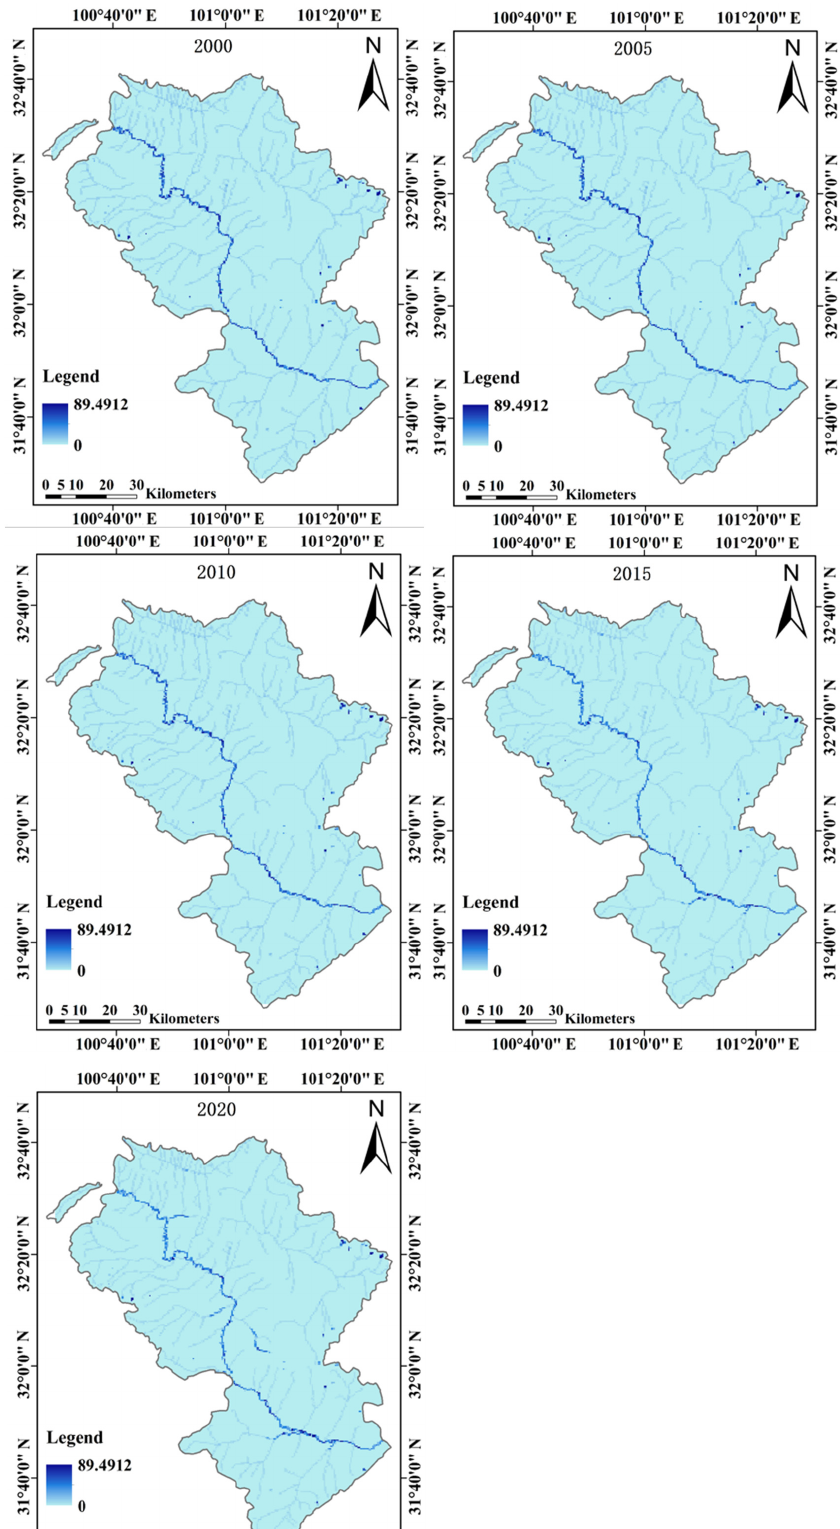
Figure 10. Water density index of Rangtang County.